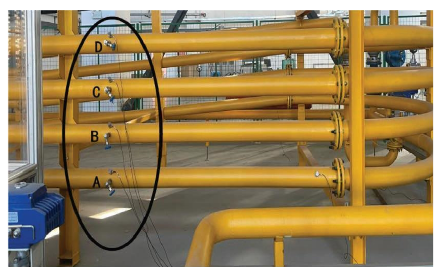
Figure 3: Physical view of the annular pipe and leak hole